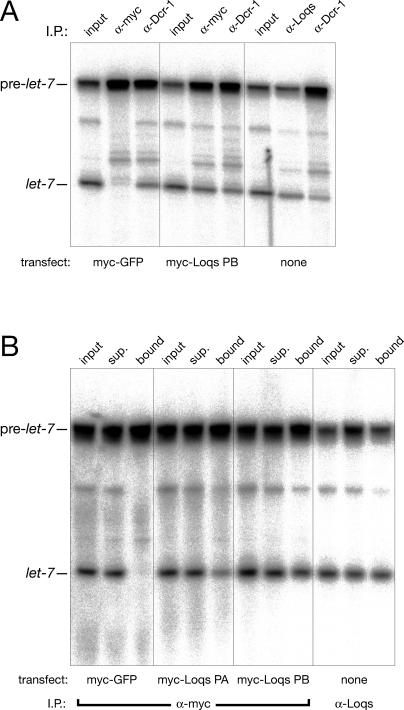
Loqs Is Associated with Pre-miRNA Processing Activity in S2 Cells(A) Pre-miRNA processing activity co-immunoprecipitates with myc-tagged Loqs PB and with endogenous Dcr-1 or endogenous Loqs, but not with myc-tagged GFP.(B) Pre-miRNA processing activity co-purifies by immunoprecipitation with both Loqs protein isoforms that interact with Dcr-1, Loqs PA, and Loqs PB. The extracts used in (A) and (B) were independently prepared.